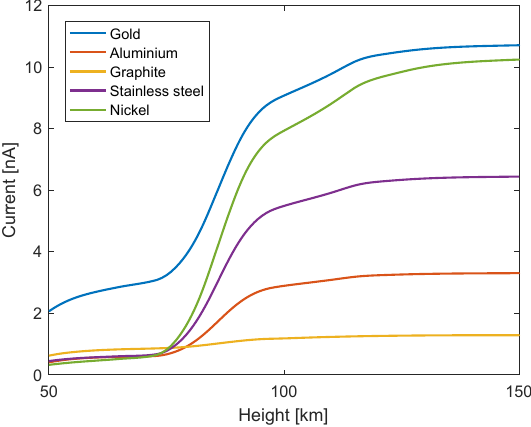
Figure 8. MSPD photocurrent at various heights for the five differ- ent materials, for an inclination angle of 0 ◦ and a solar zenith angle of 75 ◦ .